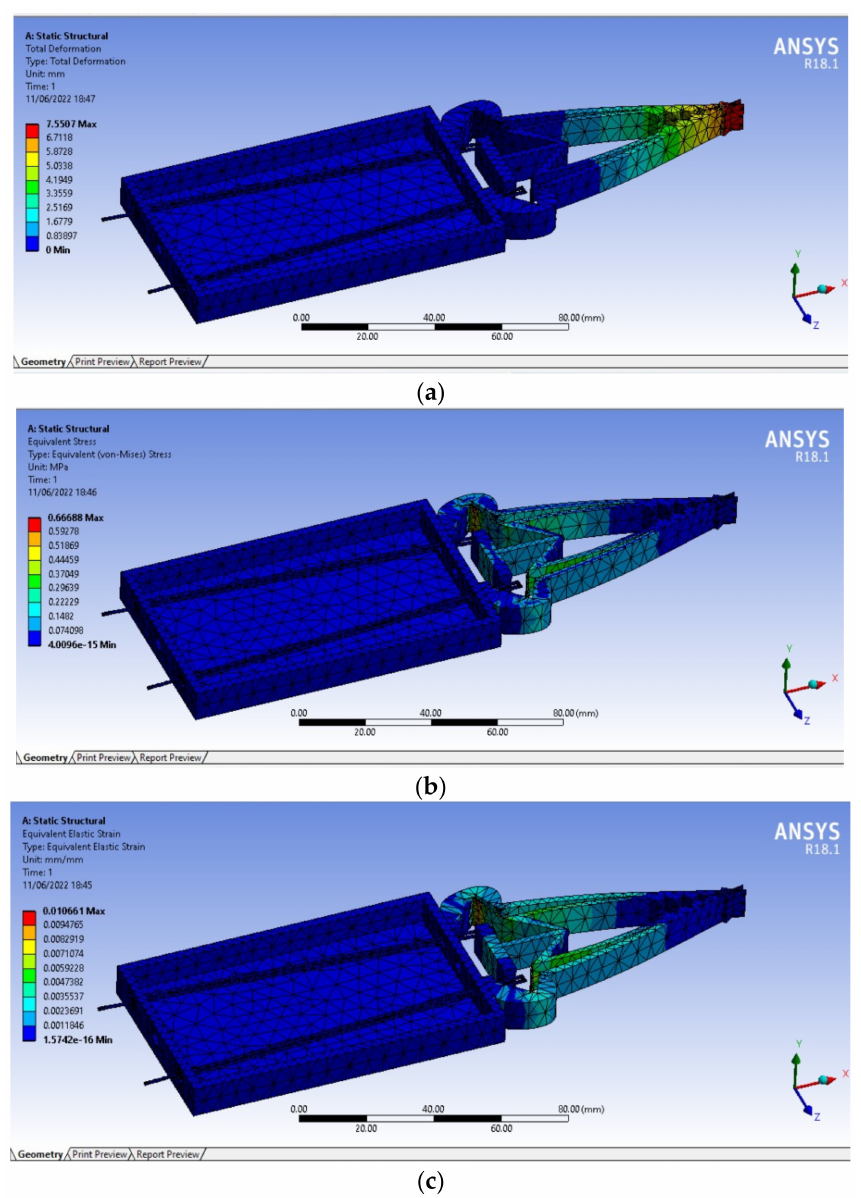
Figure 5. Numerical simulation of the gripping assembly using ANSYS; ( a ) deformation, ( b ) stress, ( c )